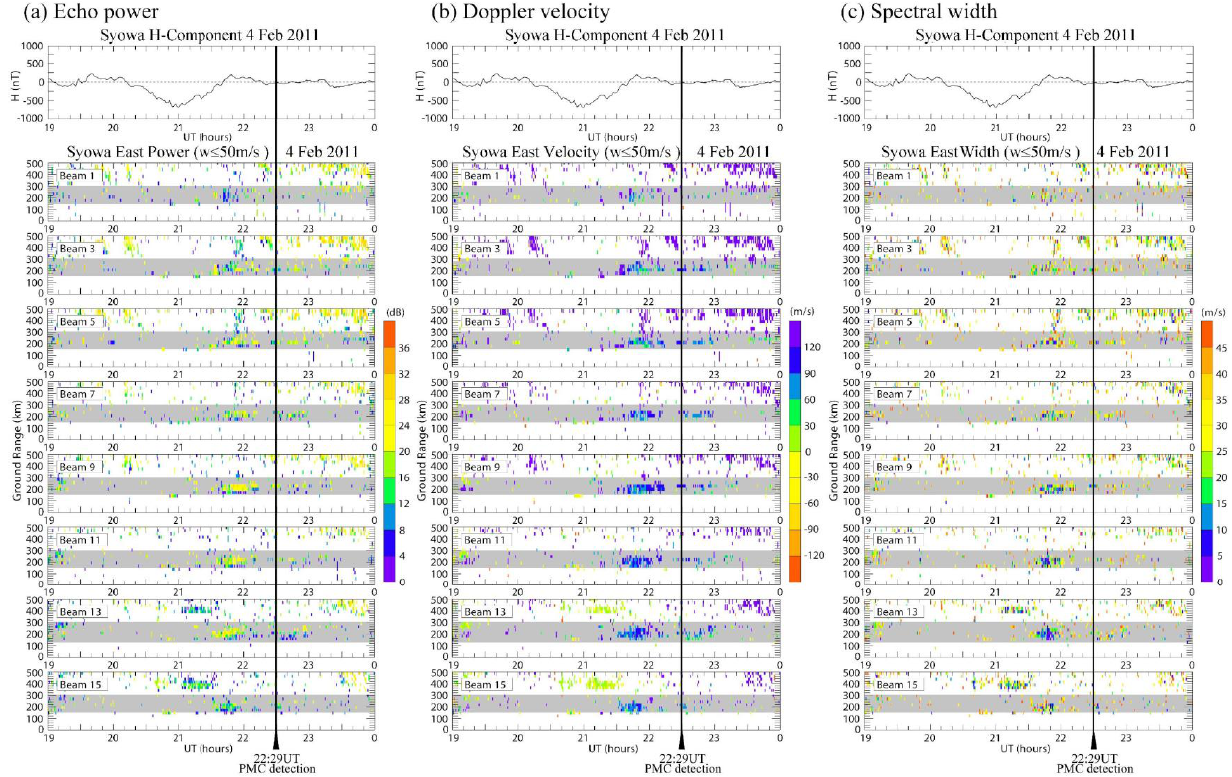
Fig. 4. Time and ground range variations of (a) echo power, (b) Doppler velocity, and (c) spectral width for beams 1, 3, 5, 7, 9, 11, 13, and 15 between 19:00 and 24:00UTC. Data with a spectral width less than 50ms − 1 are plotted. Time variation of the geomagnetic H component at Syowa Station is also shown in each figure (top panel). The most sensitive regions for PMSE detection (ground range 150–300km) are displayed with gray bands. Table 1. List of lidar observations and weather conditions in February 2011 at Syowa